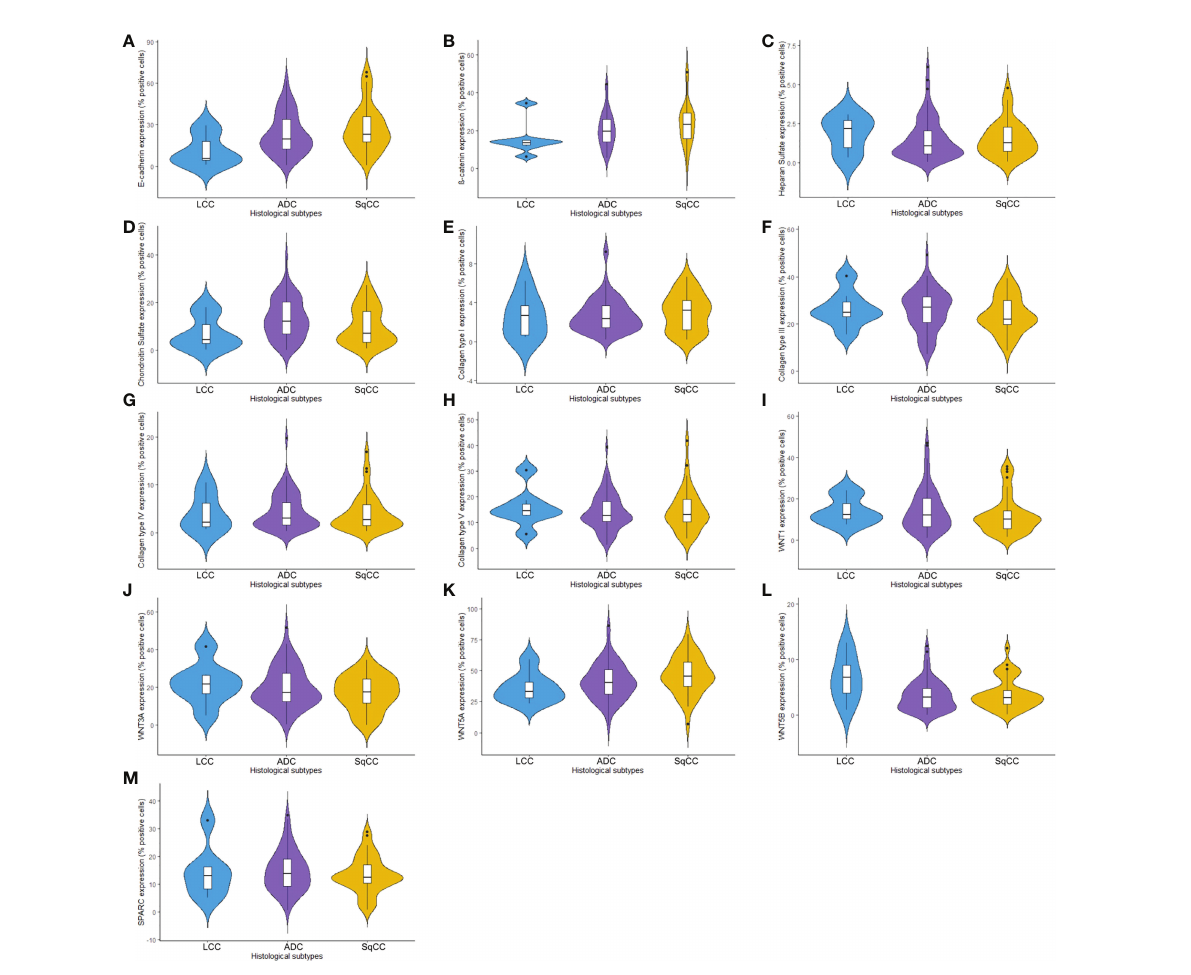
FIGURE 1 Violin plots graphs showing proteins of the epithelial-mesenchymal transition process, matricellular, and the Wnt signaling pathway expression analyzed by QuPath (N=120). The protein expression was demonstrated between three different histologic types in non-small cells lung cancer for (A) E-cadherin, (B) b -catenin, (C) Heparan sulfate, (D) Chondroitin sulfate, (E) Col I, (F) Col III, (G) Col IV, (H) Col V, (I) WNT1, (J) WNT3A, (K) WNT5A, (L) WNT5B, and (M) SPARC. LCC, large cell carcinoma; ADC, lung adenocarcinoma; SqCC, lung squamous cell carcinoma; Col, collagen